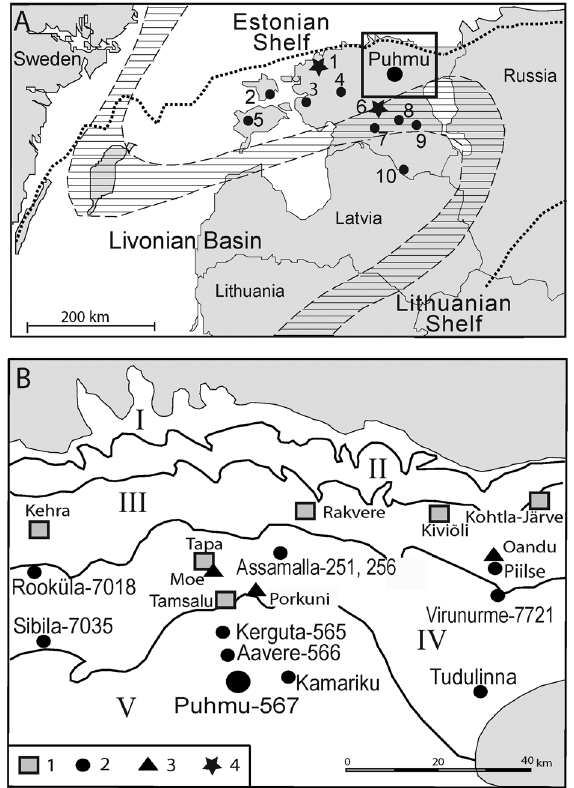
Fig. 1. ( A ) General facies zonation of the eastern part of the Baltoscandian Basin (Männil 1966, Harris et al. 2004, modified). Horizontal lines mark the transitional belt. The dotted line denotes the erosional northern limit of the area of the Ordovician rocks. Location of the Puhmu core and localities mentioned in the text: 1, Vasalemma; 2, Orjaku; 3, Kirikuküla; 4, Lelle-D102; 5, Viki; 6, Võhma; 7, Viljandi-91; 8, Laeva-18; 9, Tartu-453; 10, Valga-10. ( B ) Outcrop areas in NE Estonia (Puura 1986): I – of the Vendian to Cambrian rocks, II – Ordovician Pakerort to Uhaku RSs, III – Kukruse to Rakvere RSs, IV – Nabala to Porkuni RSs and V – of the Silurian rocks. Legend: 1, town; 2, borehole; 3, outcrop; 4, occurrences of reefs. Several boreholes have also an identification number shown here and in Fig. 1B. These numbers are not used in the text, except for Assamalla where two boreholes are under the same